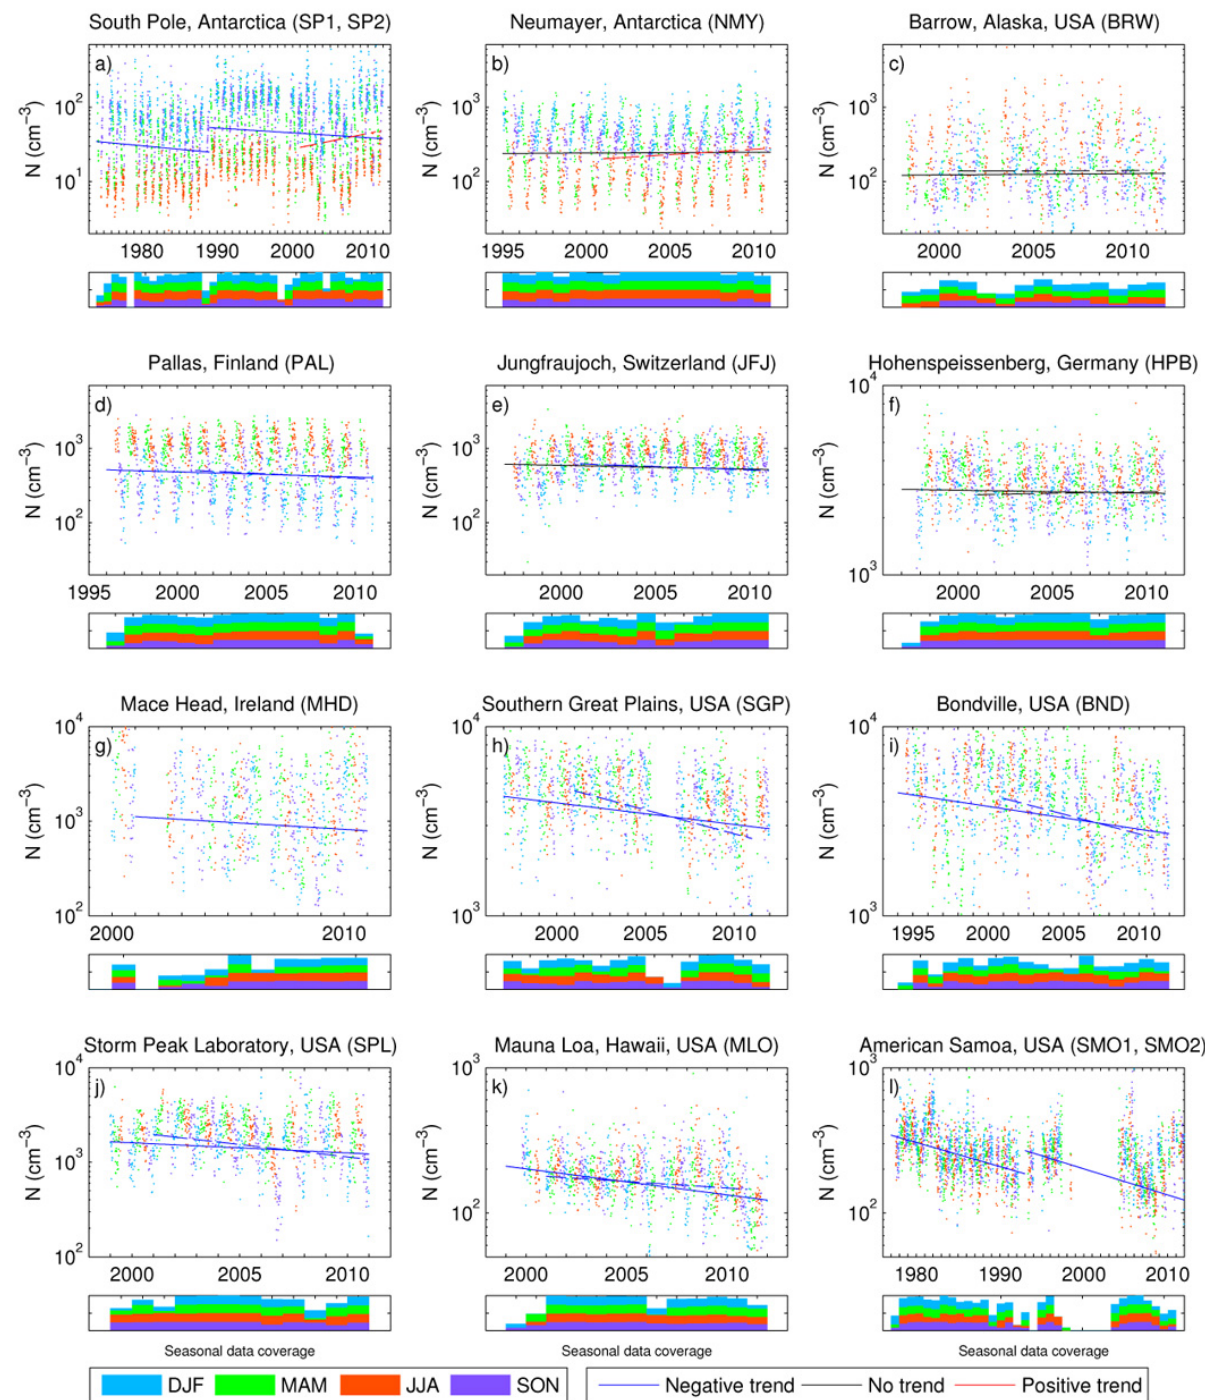
Fig. 2. Generalized least squares trends of N at the GAW stations. Different colours of the dots show the time series split into 4 seasons as shown in the legend (DJF: December–February, MAM: March–May, JJA: June–August and SON:September–November). Lines show the GLS trend (increasing: red, decreasing: blue, no s.s. trend: black). Each plot includes the GLS trend and, where possible, the trend for period of 2001–2010 (dashed lines). Data coverage per season is shown below each subplot. For SPO and SMO separate trends for datasets with different instruments are